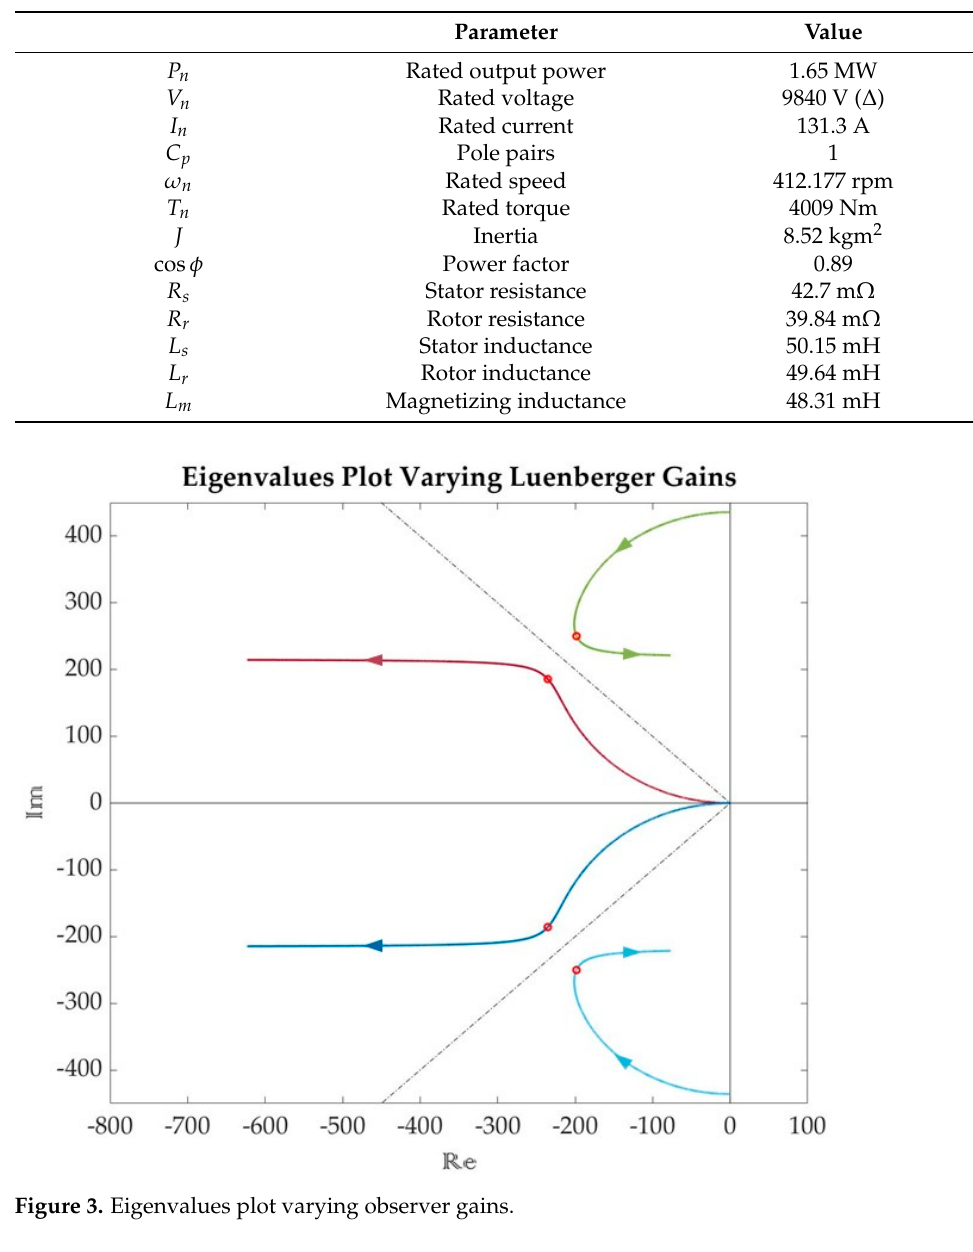
From this analysis, one derives that these two gains lead the system to stability and guar- antee the best dynamic performance; there are other gains that lead to stability, but they do not guarantee the same dynamic properties. Furthermore, stability of these gains must be studied by varying the motor speed. In Figure 4 the latter analysis is shown. Figure 4. Eigenvalues plot varying motor speed.